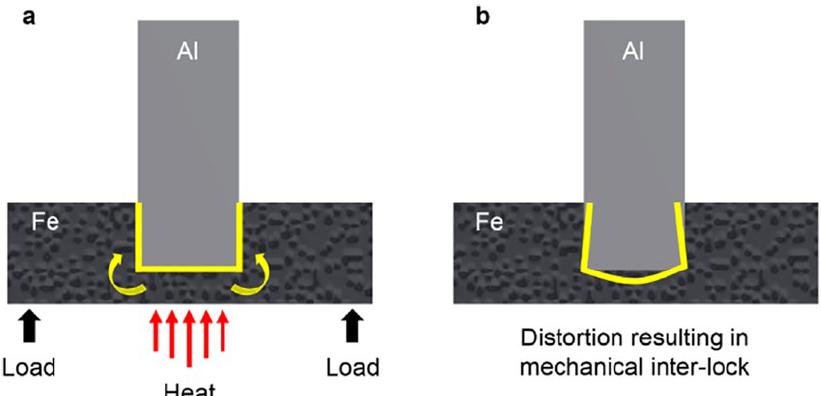
Figure 10. Schematic representation of the mechanical inter-lock induced during the welding pro- cess [32]. ( a ) heating process, ( b ) mechanical interlock